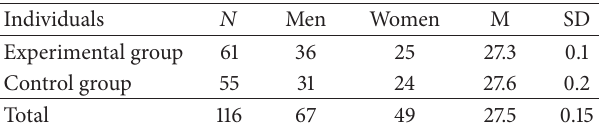
Table 1: Research